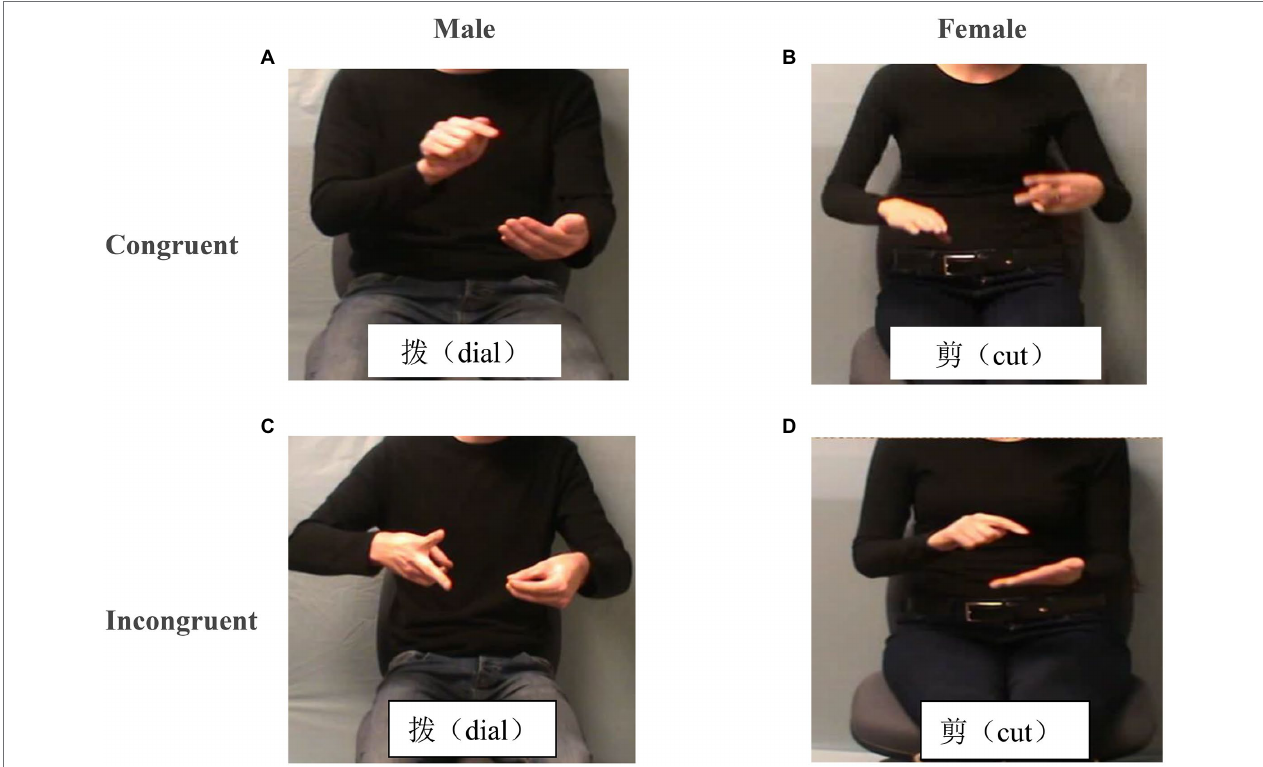
FIGURE 1 | Semantically congruent and incongruent Stroop-like gesture–speech integration (GSI) task paradigm. Illustrations of the stimuli. In the gesture- congruent condition (picture A , B ), the gesture and the speech were semantically related (e.g., gesturing dial and saying “ dial ” or gesturing cut and saying “ cut ”), and in the gesture-incongruent condition (picture C , D ), they were semantically unrelated (e.g., gesturing cut and saying “ dial ,” and vice versa). There was a gender manipulation that varied the relationship between the gesturer and the speaker. In the gender-same condition, the gesturer and the speaker were the same person (a man or a woman), but in the gender-different condition, the gesturer and the speaker were two different people (e.g., a man gesturing but a woman speaking, and vice